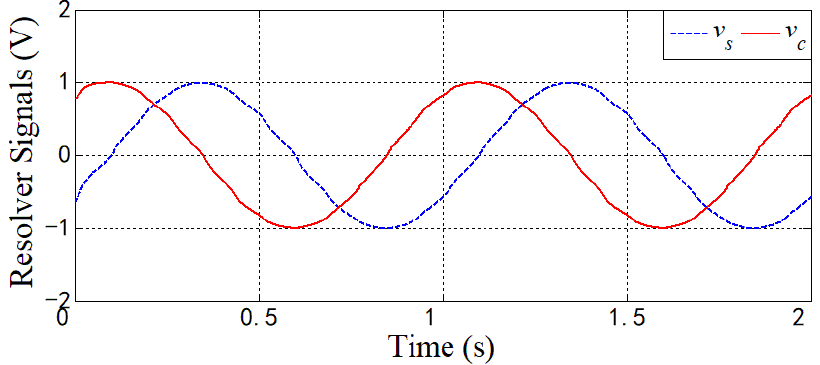
Figure 12. Resolver signals at fixed speed in experiment.